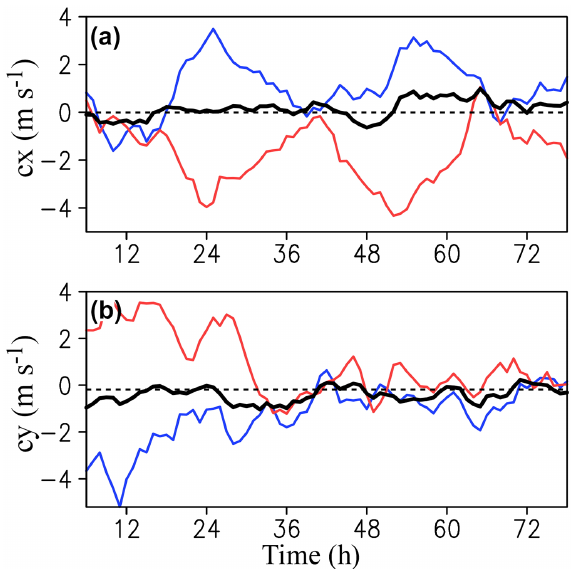
Figure 11. Time series of the contributions of diabatic heating at 700 (blue) and 400hPa (red), and the contribution of diabatic heat- ing (thick black) averaged over the layer between 300 and 850hPa.